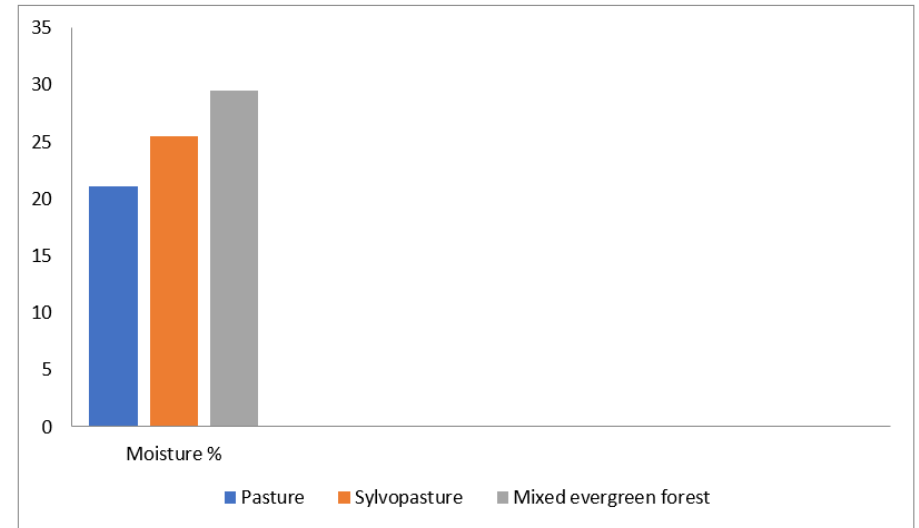
Figure 3. Declining of soil temperature from Pa to SP to MEF.